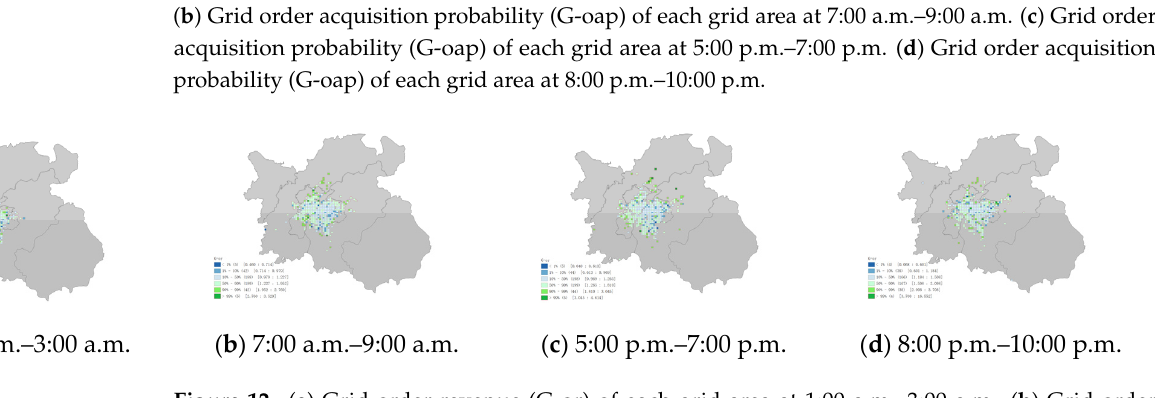
Figure 12. ( a ) Grid order revenue (G-or) of each grid area at 1:00 a.m.–3:00 a.m. ( b ) Grid order revenue (G-or) of each grid area at 7:00 a.m.–9:00 a.m. ( c ) Grid order revenue (G-or) of each grid area at 5:00 p.m.–7:00 p.m. ( d ) Grid order revenue (G-or) of each grid area at 8:00 p.m.–10:00 p.m.